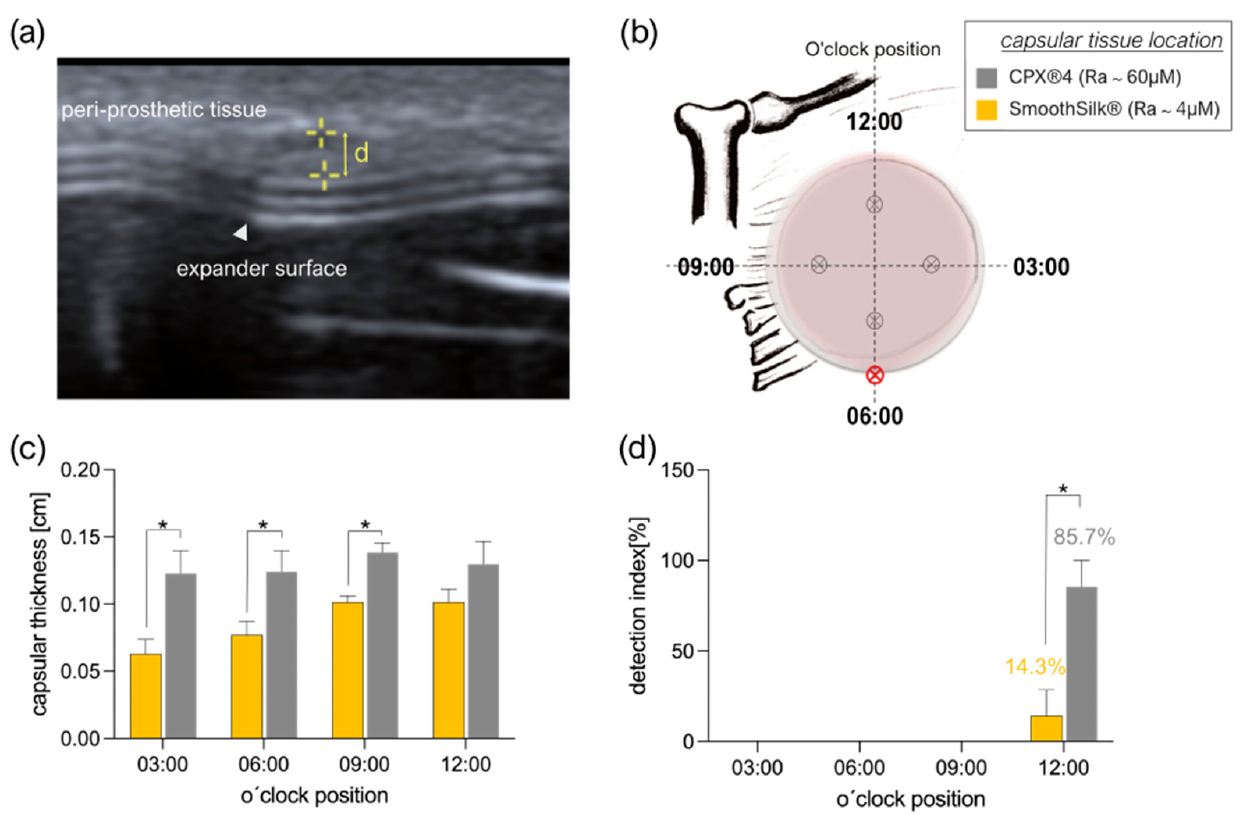
Figure 6. Ultrasonographic measurement of fibrotic peri-prosthetic capsule thickness of 7 patients was defined as the distance ( a ) from the silicon tissue expander surface to the outer margin of the capsule at the widest portion of the capsule and determined bilaterally at ( b ) o’clock reference po- sitions 00:00, 03:00, 06:00, 09:00, 12:00 for the left and right breast. ( c ) Statistical significance was